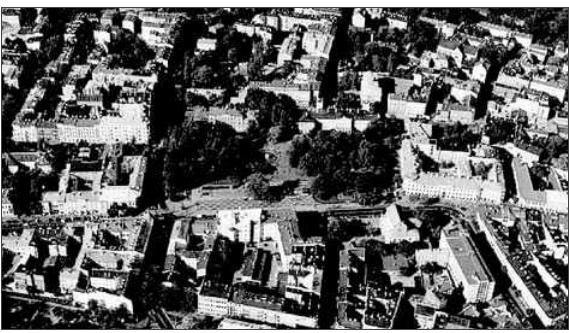
20 pav. Skvero sutvarkymo pasiūlymas (archit. G. Čaikauskas, S. beyer) Fig. 20. Proposal for reconstruction of the square (archs. G. Čaikauskas, S.